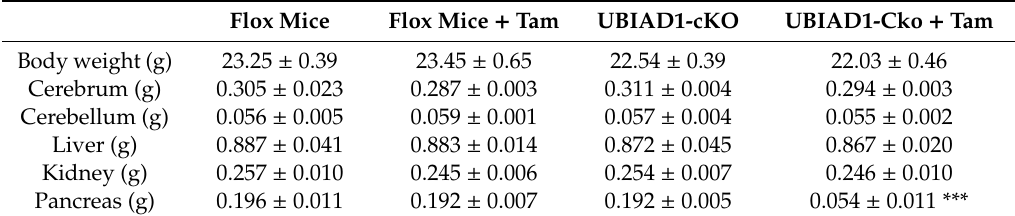
Table 1. Body and tissue weights in the tamoxifen-treated and untreated Flox and UbiA prenyltransferase